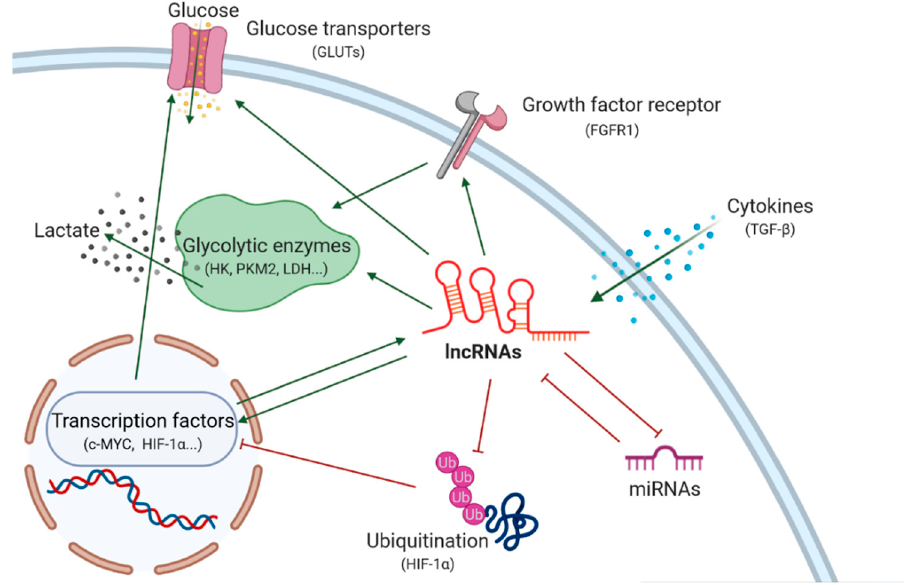
Figure 2. Schematic representation of glucose metabolism regulation in cancer by lncRNAs (created with BioRender.com).